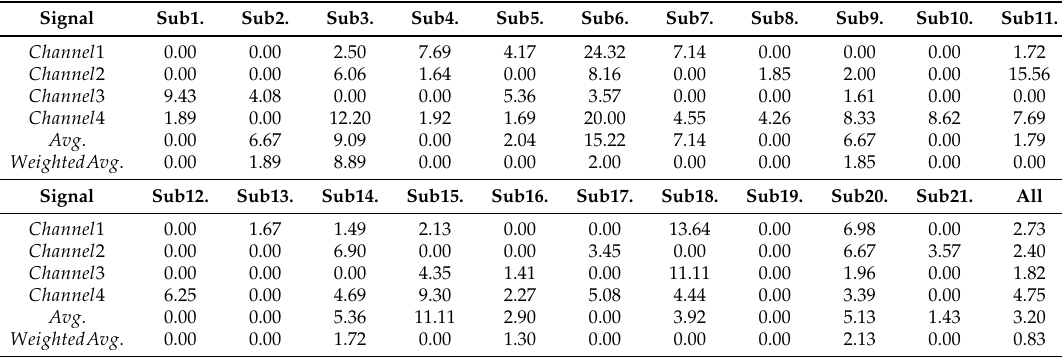
Table 4. Failed detection rate (%) of each subject for rapid horizontal movement. Signal Sub1. Sub2.